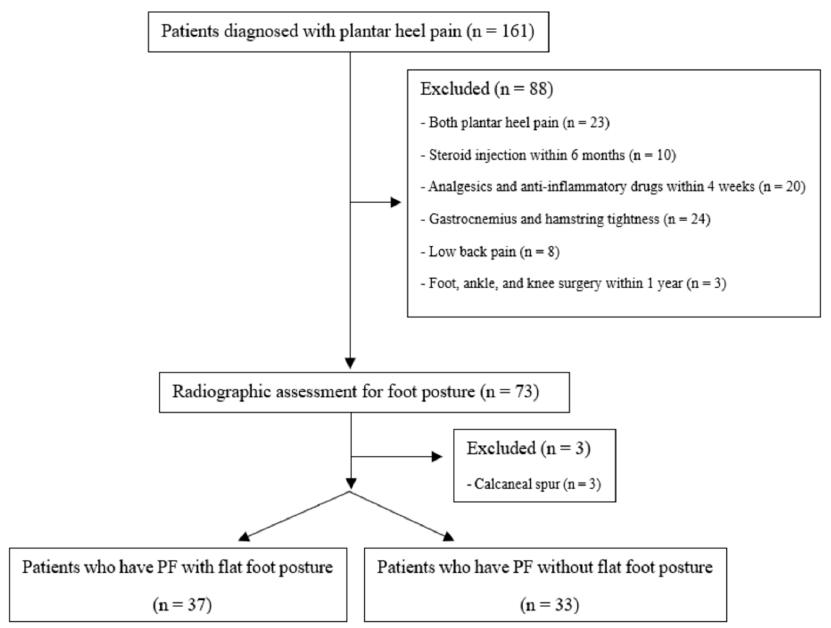
Figure 1. Flowchart of patients with plantar heel pain.